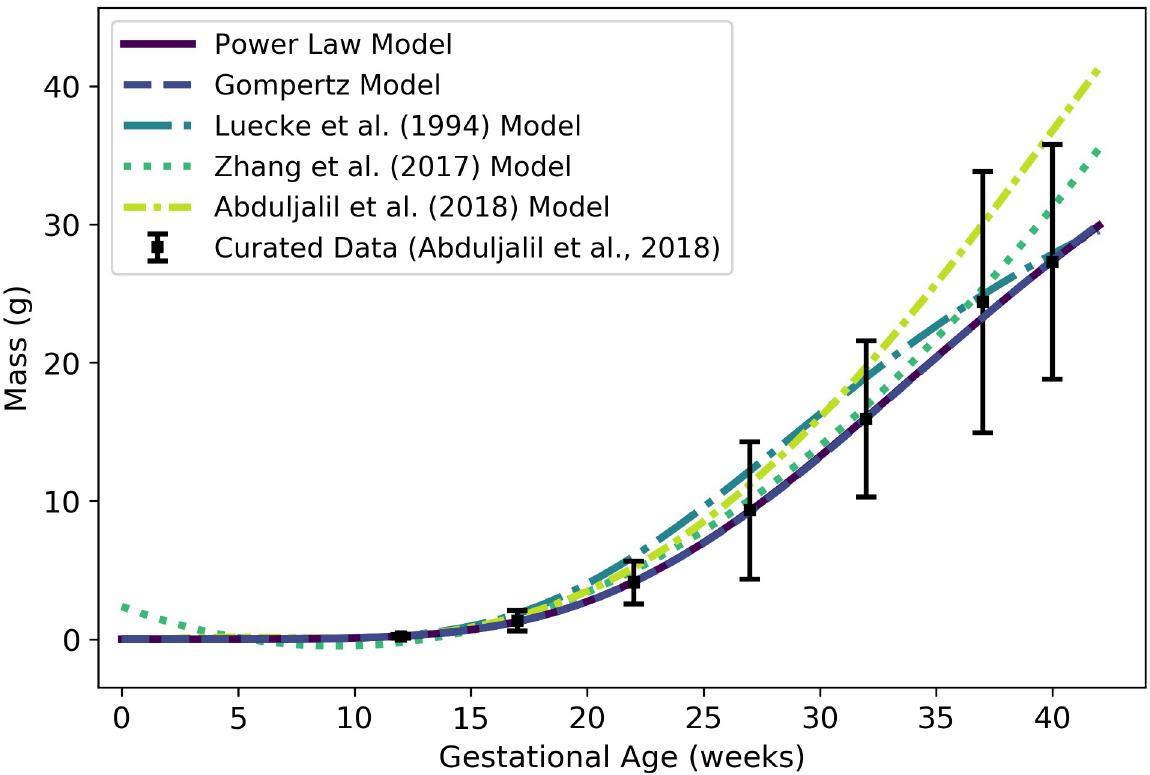
Fig 17. Fetal kidney mass vs. gestational age. The power law model (solid line) given by Eq 34 was selected as the most parsimonious model in our analysis; however, that model is a function of fetal mass. The Gompertz model (dashed line) given by Eq 35 may be preferred since it is a function of gestational age and does not require an intermediate model for fetal mass. Note that the Gompertz model and the power law model are virtually indistinguishable in this plot. The model of Luecke et al. [15], which is also a power law model based on fetal mass, was calibrated using a different data set [25]. The model of Zhang et al. [32] was also calibrated using a distinct compiled data set. The Zhang et al. [32] model describes kidney volume, so the units were converted assuming a tissue density of 1 g/mL. The apparently poor fit of the model of Abduljalil et